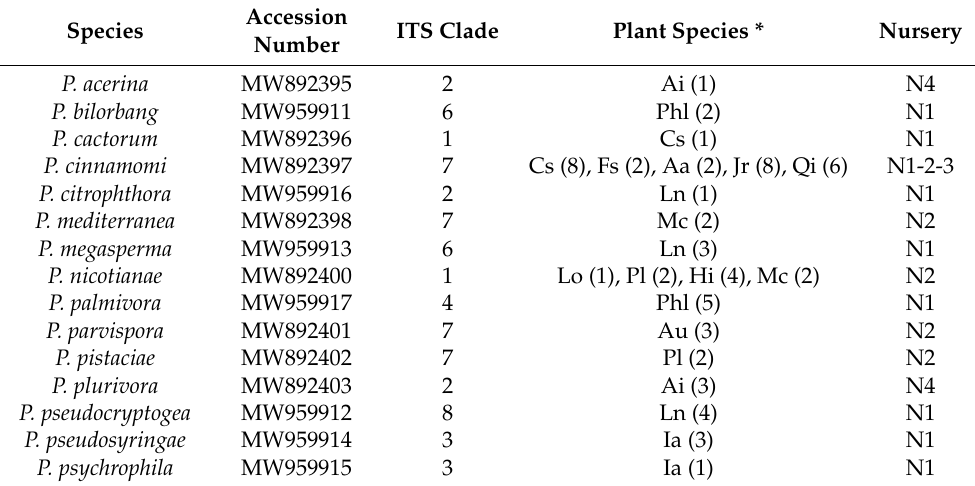
Table 3. Number of isolates of Phytophthora species obtained from monitored plants in the investi- gated